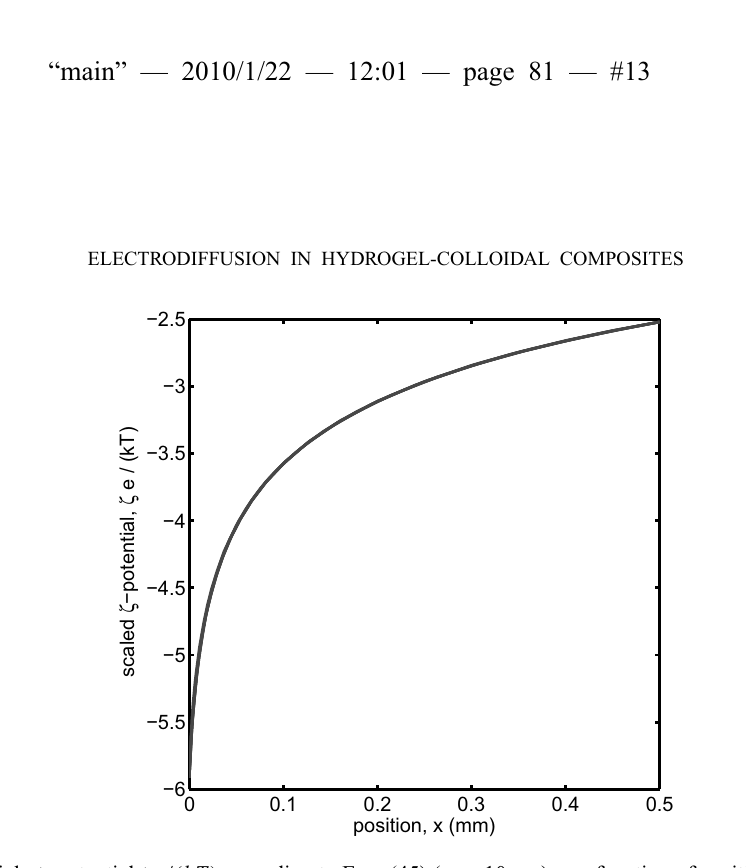
Fig. 1 – Scaled particle ζ -potential ζ e /( kT ) according to Eqn. (45) ( a = 10 nm) as a function of position x (mm) with constant particle surface charge density σ = 1 μ C cm − 2 . The accompanying bulk ionic strength varies approximately linearly with position: h I i ≈ 0 . 01 + ( 10 − 0 . 01 )( x / L ) mmol l − 1